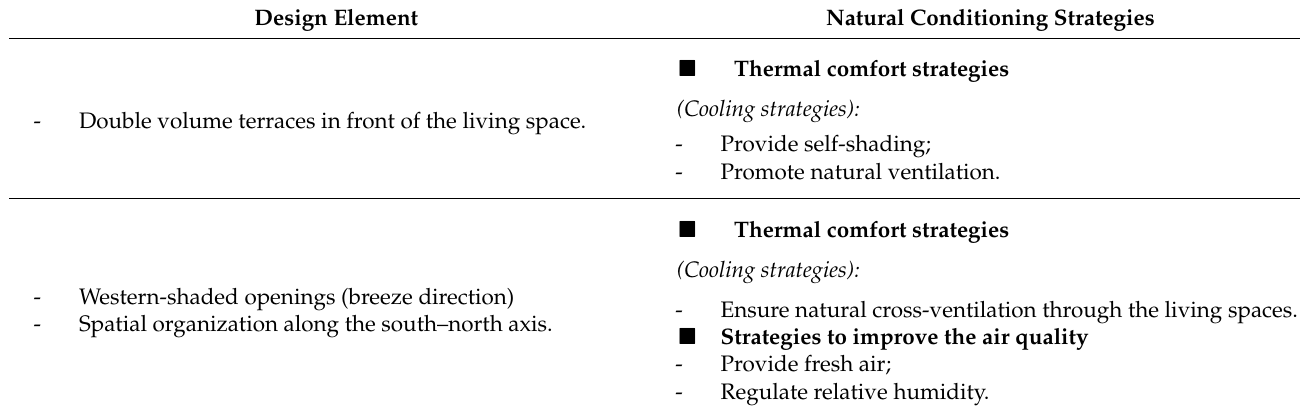
Table 3. The traditional bioclimatic design strategies and techniques used in Kanchanjunga Apartments.